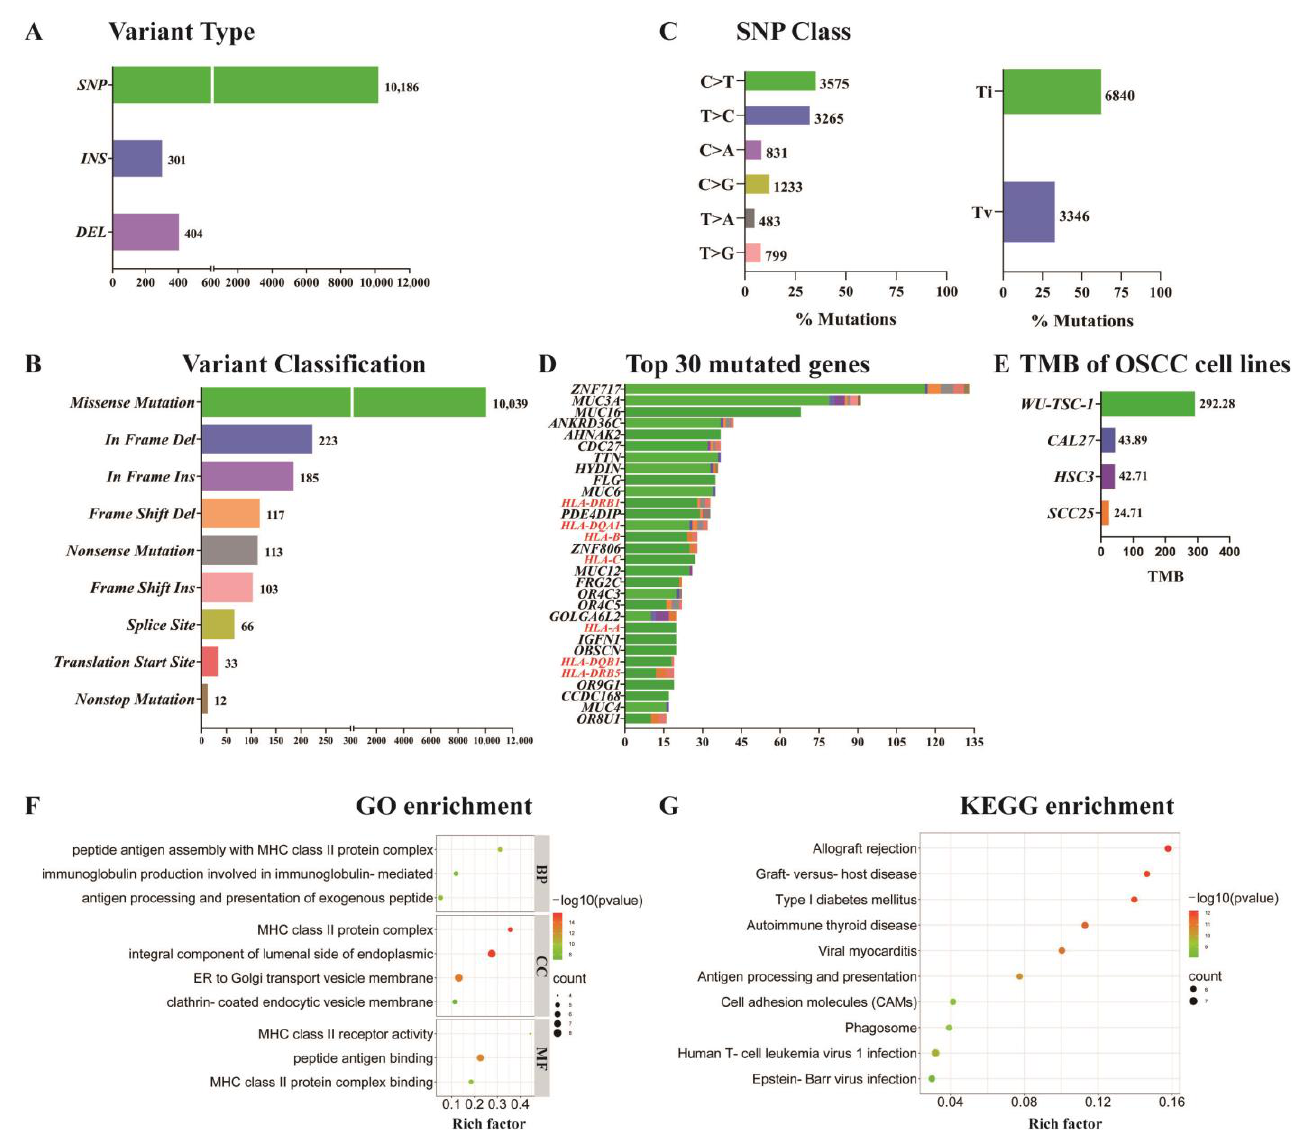
Figure 4. SNP/InDel mutation of WU-TSC-1: ( A ) Variant types of non-synonymous somatic mu- tations detected in WU-TSC-1. ( B ) Summary of mutations by function showed nonsynonymous mutations in WU-TSC-1 were mainly missense mutations. ( C ) SNP classification of WU-TSC-1. ( D ) Top 30 high frequency mutated genes in WU-TSC-1. ( E ) TMB of WU-TSC-1, CAL27, HSC3 and SCC25. ( F ) GO enrichment analysis of high frequency mutated genes (BP: biological process, CC: cellular component, MF: molecular function). ( G ) KEGG enrichment analysis of high frequency mutated genes.